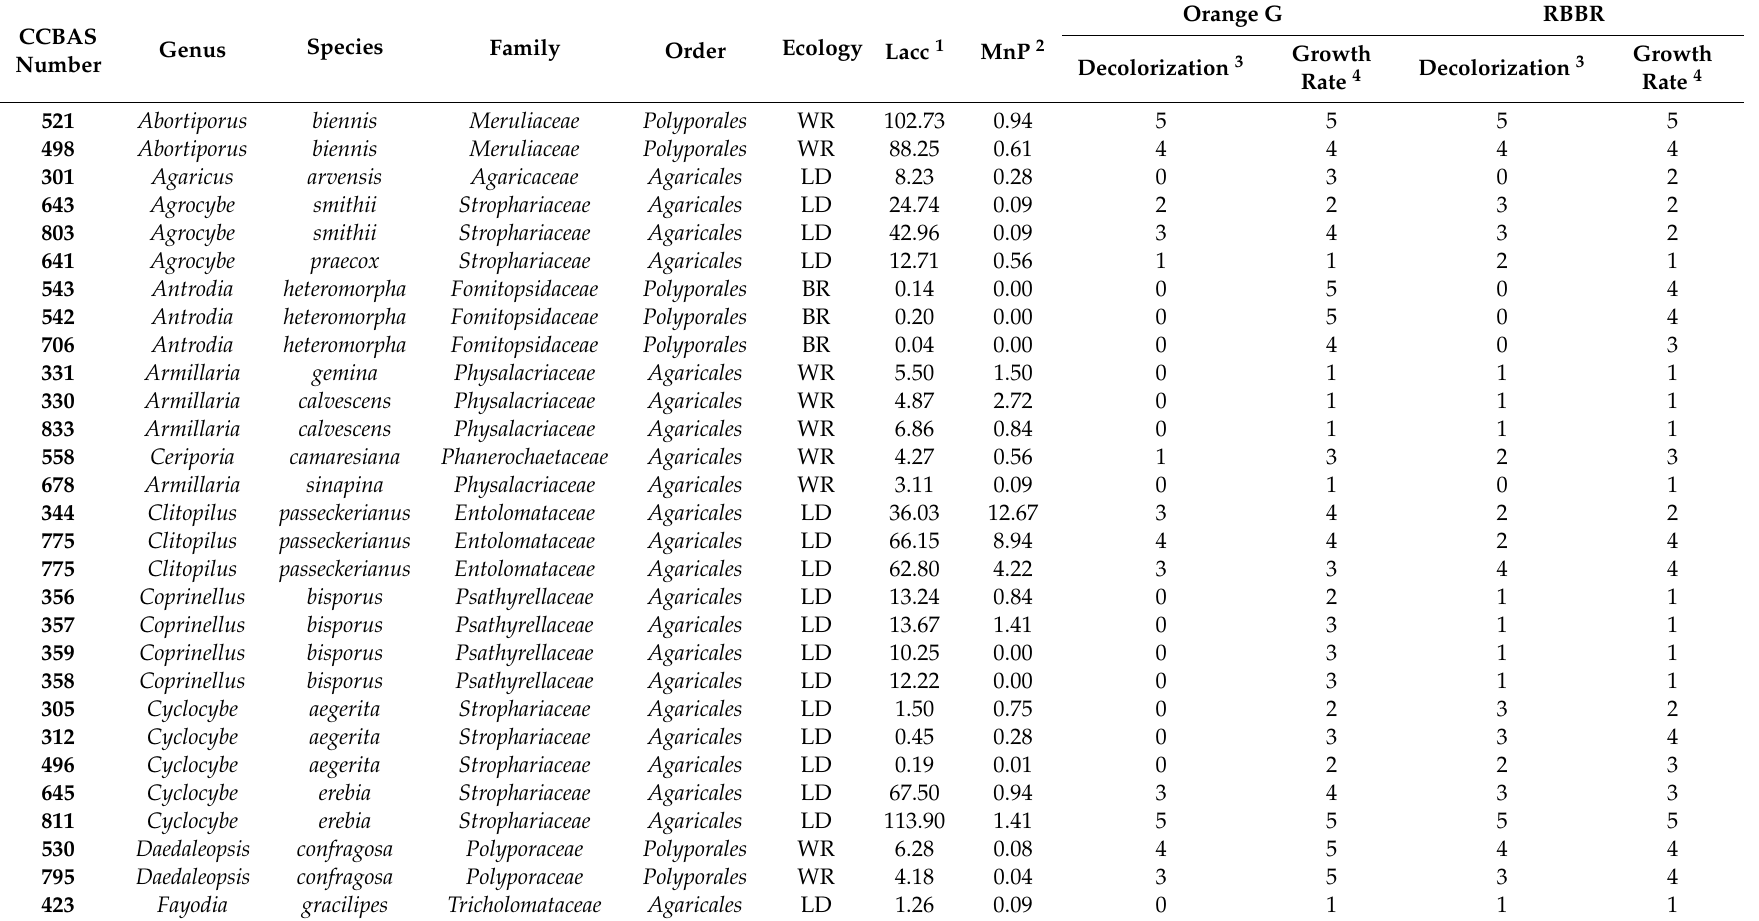
Table 4. Decolorization capacities and ligninolytic enzyme production in saprotrophic Basidiomycetes. Abbreviations: WR—white rot, BR—brown rot, LD—litter